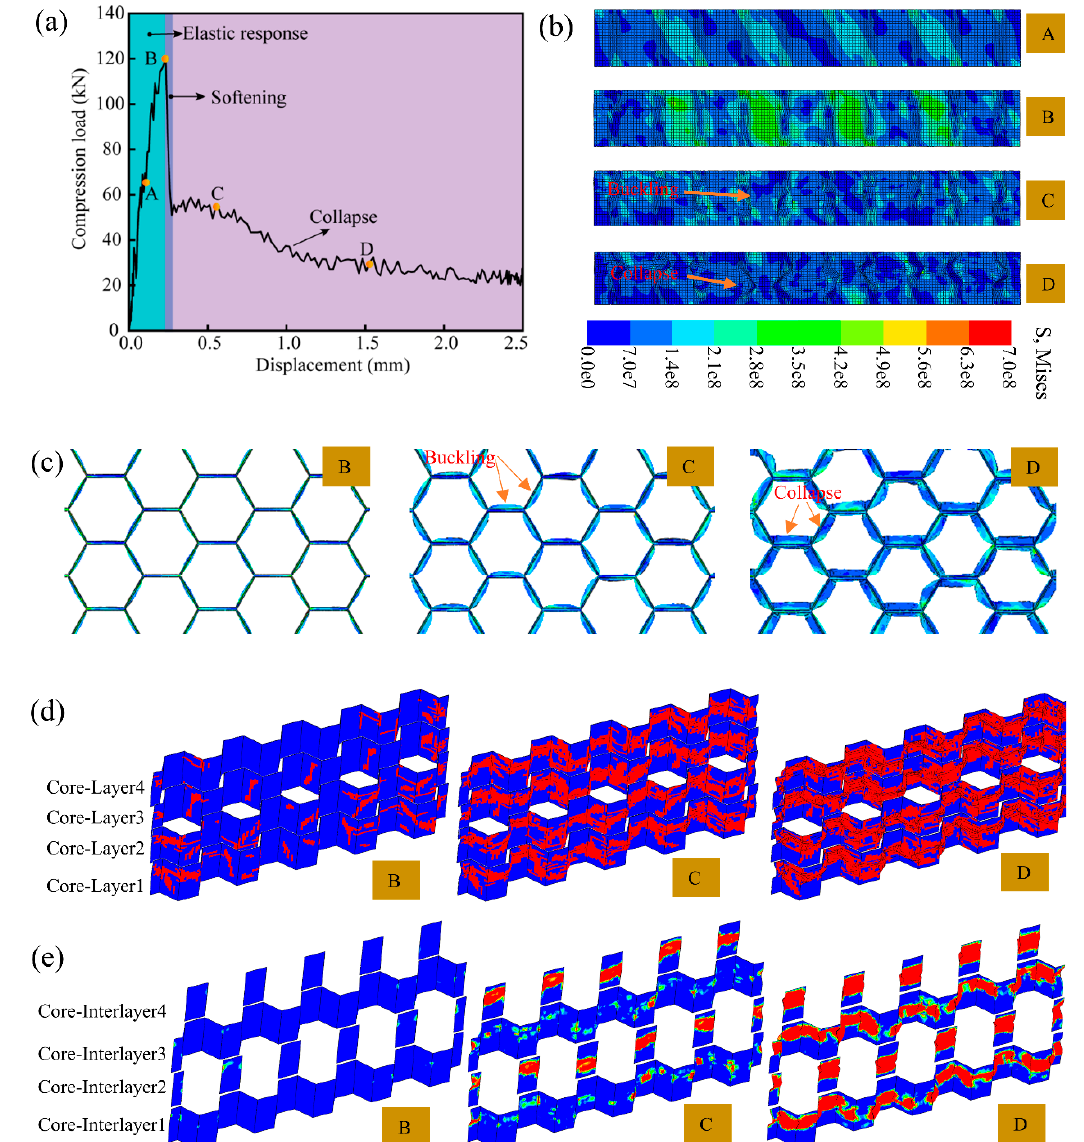
Figure 6. Damage evolution of all-composites under quasi-static out-of-plane compression: ( a ) compression-load–displacement curve, ( b ) the stress contour plot and deformation state of honeycomb core (front view), ( c ) the deformation state of honeycomb core (top view), ( d ) matrix damage distribution of honeycomb core, and ( e ) delamination distribution of the Core-Interlayer1–4.